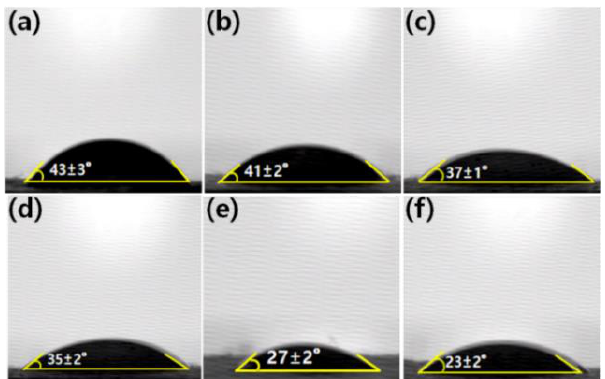
Figure 7. Contact angle of polyacrylonitrile (PAN), graphene oxide modified by polydiallyldimethylammonium chloride/polyacrylonitrile (GP/PAN) hybrid nanofiber membranes; ( a ) PAN nanofiber membrane, ( b ) GP01PAN, ( c ) GP02PAN, ( d ) GP03PAN, ( e ) GP04PAN, ( f ) GP10PAN.